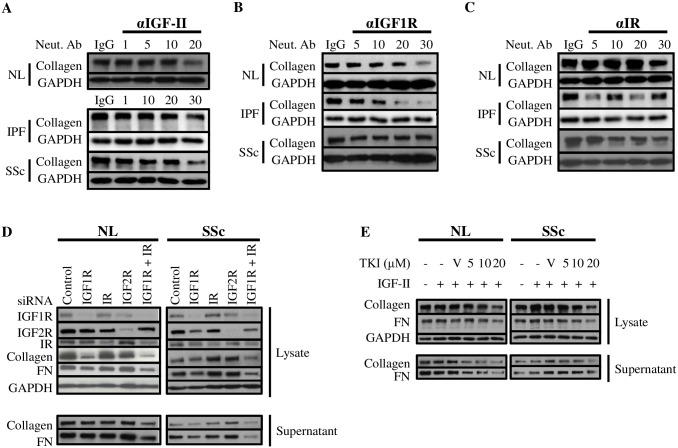
Blockade of endogenous IGF-II or its receptors abrogates ECM component production.NL, IPF, and SSc lung fibroblasts were treated with neutralizing antibodies to endogenous IGF-II (A), IGF1R (B), IR (C), or appropriate isotype control (respective highest antibody concentration, 20–30 μg/mL) for 1 hr, followed by stimulation with IGF-II (200 ng/mL) for 48 hr and lysates were probed for Collagen and GAPDH by immunoblot. D: Lung fibroblasts were subjected to knockdown of IGF1R, IR, IGF2R, dual knockdown of IGF1R + IR, or scrambled siRNA in the presence of IGF-II (200 ng/mL) and probed for protein expression of Collagen, Fibronectin (FN), and GAPDH in lysates and supernatants. E: Lung fibroblasts were treated with increasing concentrations of IGF1R tyrosine kinase inhibitor (TKI, Tyrphostin AG 538) in the presence of 200 ng/mL IGF-II and probed for protein expression of Collagen, Fibronectin, and GAPDH in lysates and supernatants. Representative immunoblots from at least three experiments.